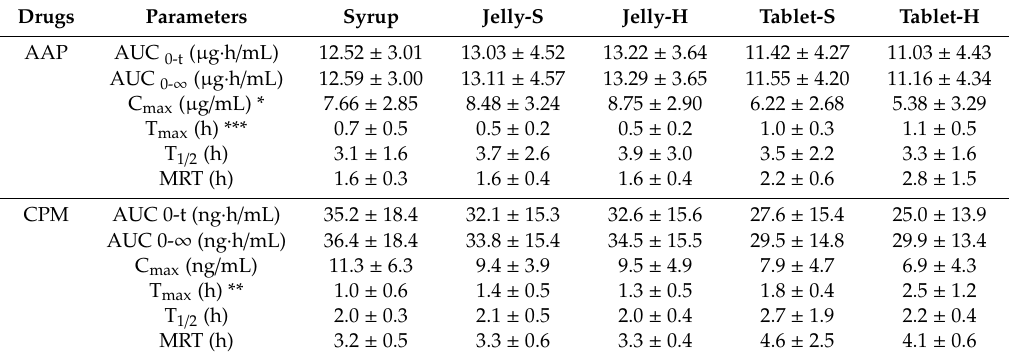
Figure 5. Plasma concentration-time profile of ( A ) AAP, ( B ) CPM, ( C ) DMH, and ( D ) MEH in dogs after oral administration of various formulations at a dose of 150, 1.875, 18.75, and 11.25 mg, respectively. Each point represents mean ± standard deviation ( n = 15). Table 4. Pharmacokinetic parameters after single oral administration of various formulations ( n = 15). Each value is expressed as an arithmatic mean ± standard deviation.